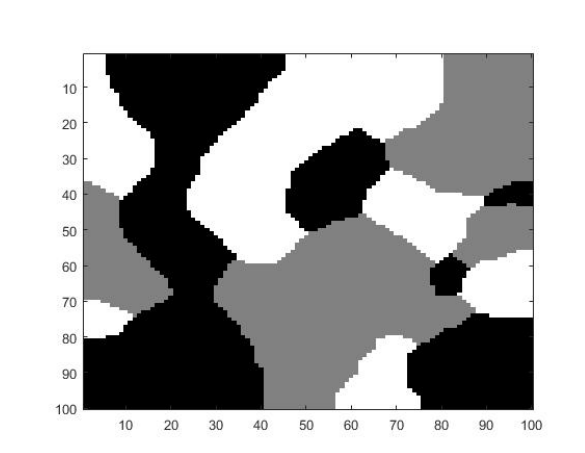
Figure 1. The label